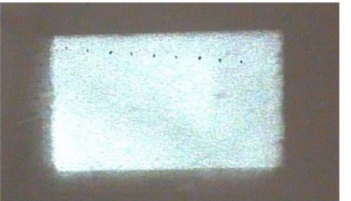
Figure 23. Light spot image at the distance of 20 m.